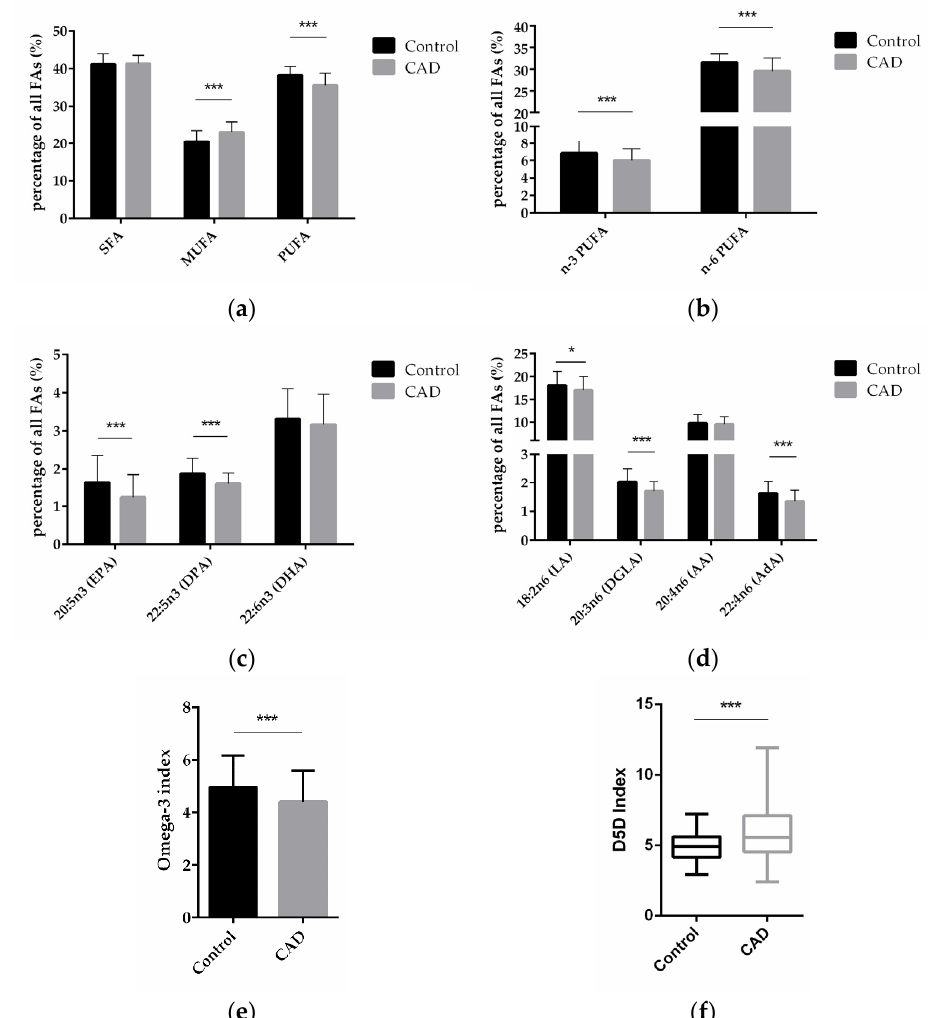
Figure 1. FA levels in blood from patients without and with CAD. ( a ) Relative content of SFAs, MUFAs, and PUFAs in control and CAD patients. ( b ) Relative content of n-3 and n-6 PUFAs in control and CAD groups. ( c ) Comparison of individual n-3 PUFAs in CAD and control patients. ( d ) Comparison of individual n-6 PUFAs in CAD and control patients. ( e ) n-3 index in control and CAD group. ( f ) D5D index as indicator of desaturase activity in CAD versus control patients. ( n = 81 for the control group, and n = 192 for the CAD group; * indicates 0.01 < p < 0.05, *** indicates p < 0.001).